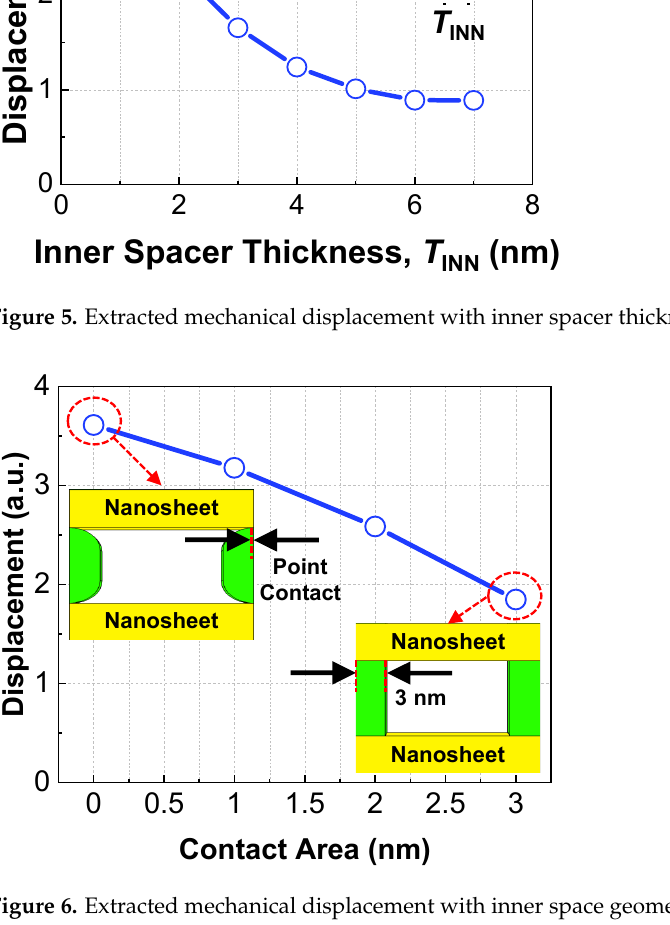
Figure 5. Extracted mechanical displacement with inner spacer thickness ( T INN ).